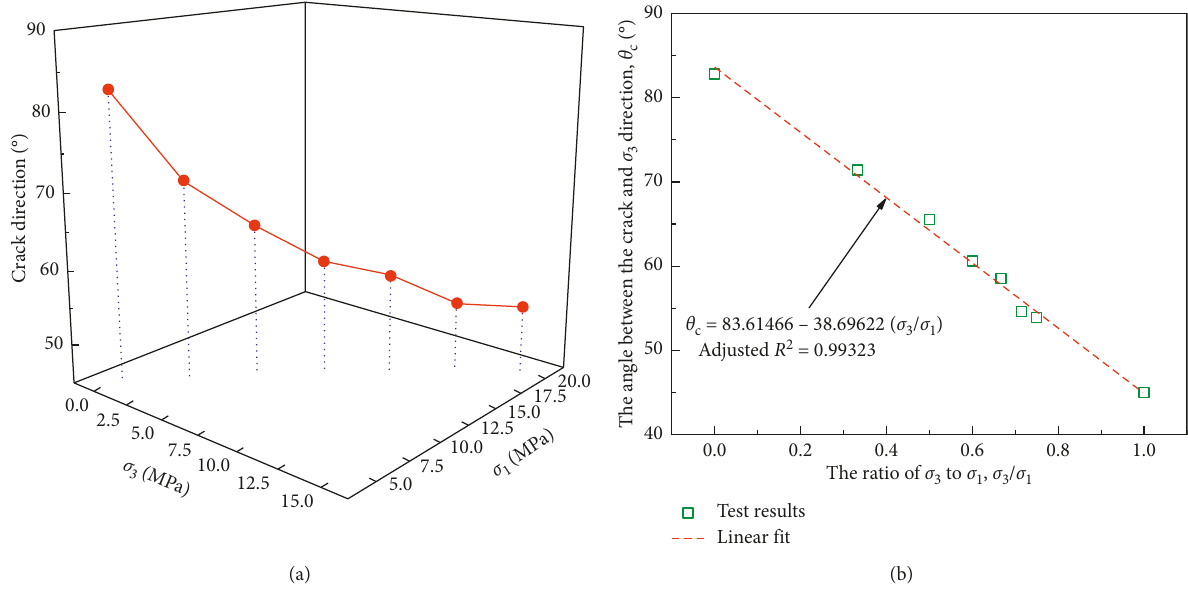
Figure 16: Variation of the SCA-induced crack direction with respect to (a) σ